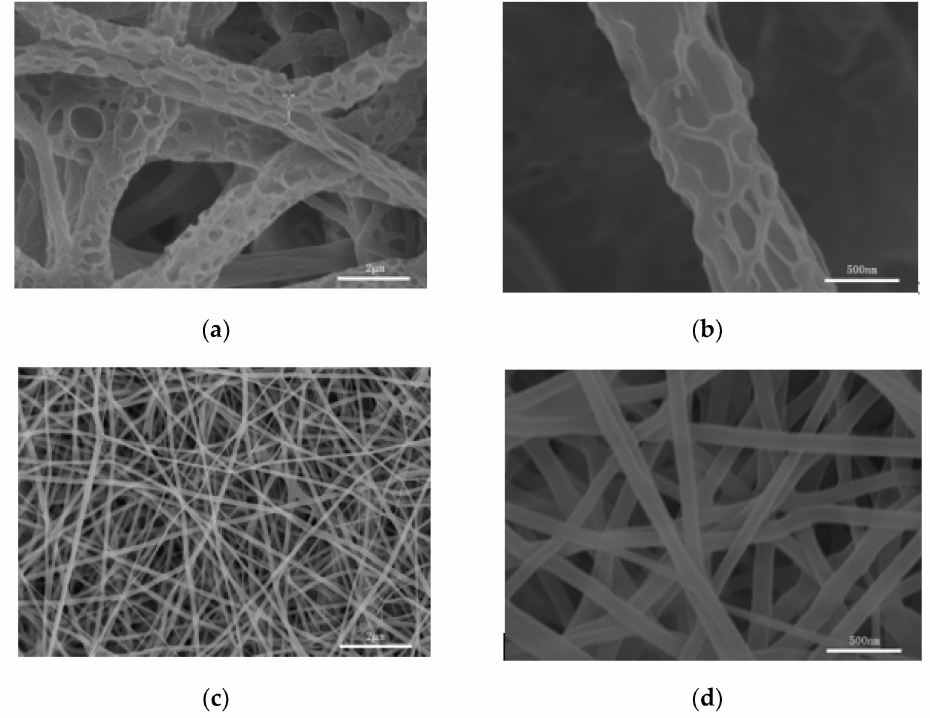
Figure 3. SEM images of nanofibers ( a , b ) PR1, ( c , d ) PR2, as prepared by uniaxial